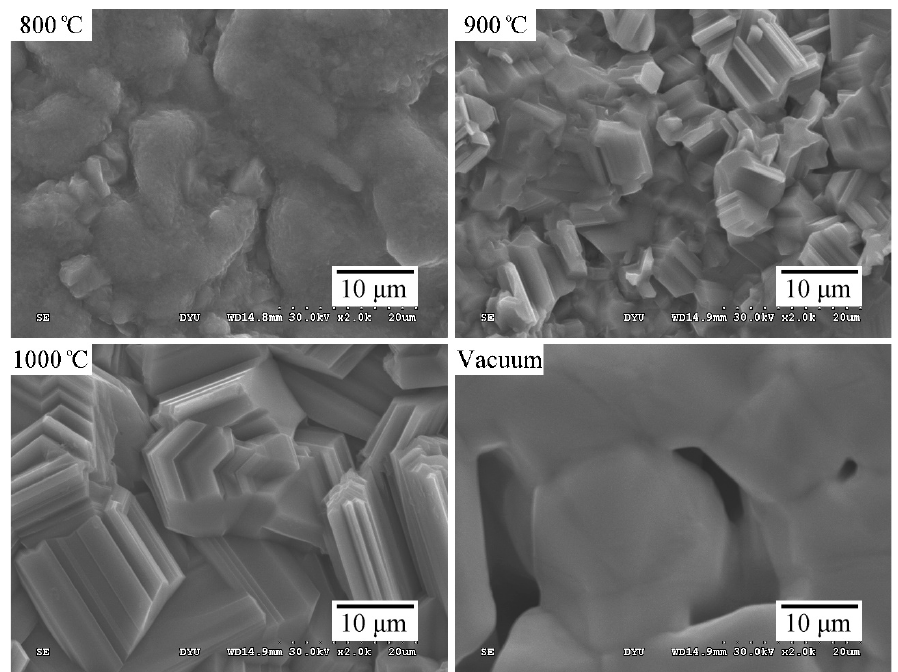
Figure 2. Scanning electron microscopy (SEM) micrographs of the strut surfaces of Ti foams sintered at 800, 900, and 1000 °C in air and of the strut surfaces of a Ti foam sintered at 1100 °C in vacuum.